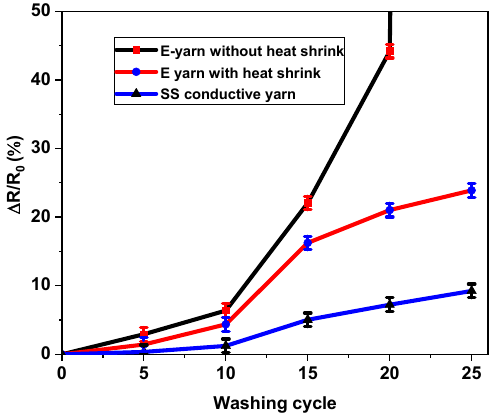
Figure 9. Effects of washing on the electrical resistance.